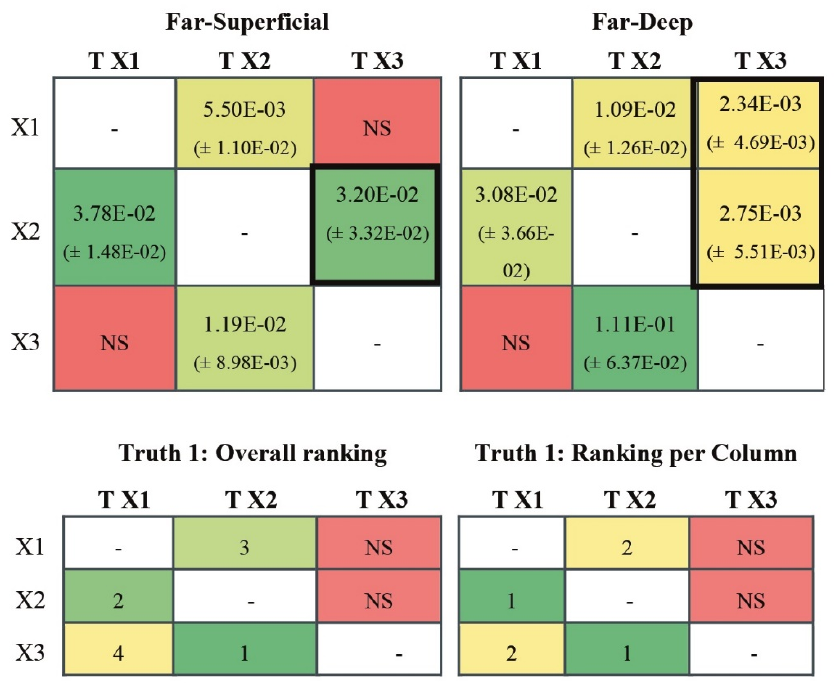
Figure 10. LSTM-NUE, Neural-Network Granger Scores rankings (Top) versus Truth 1 (Bottom), excluding self-connectivity. Color coding: dark green > light green > yellow > orange > red. The columns represent the targets, the rows the time series used for prediction.